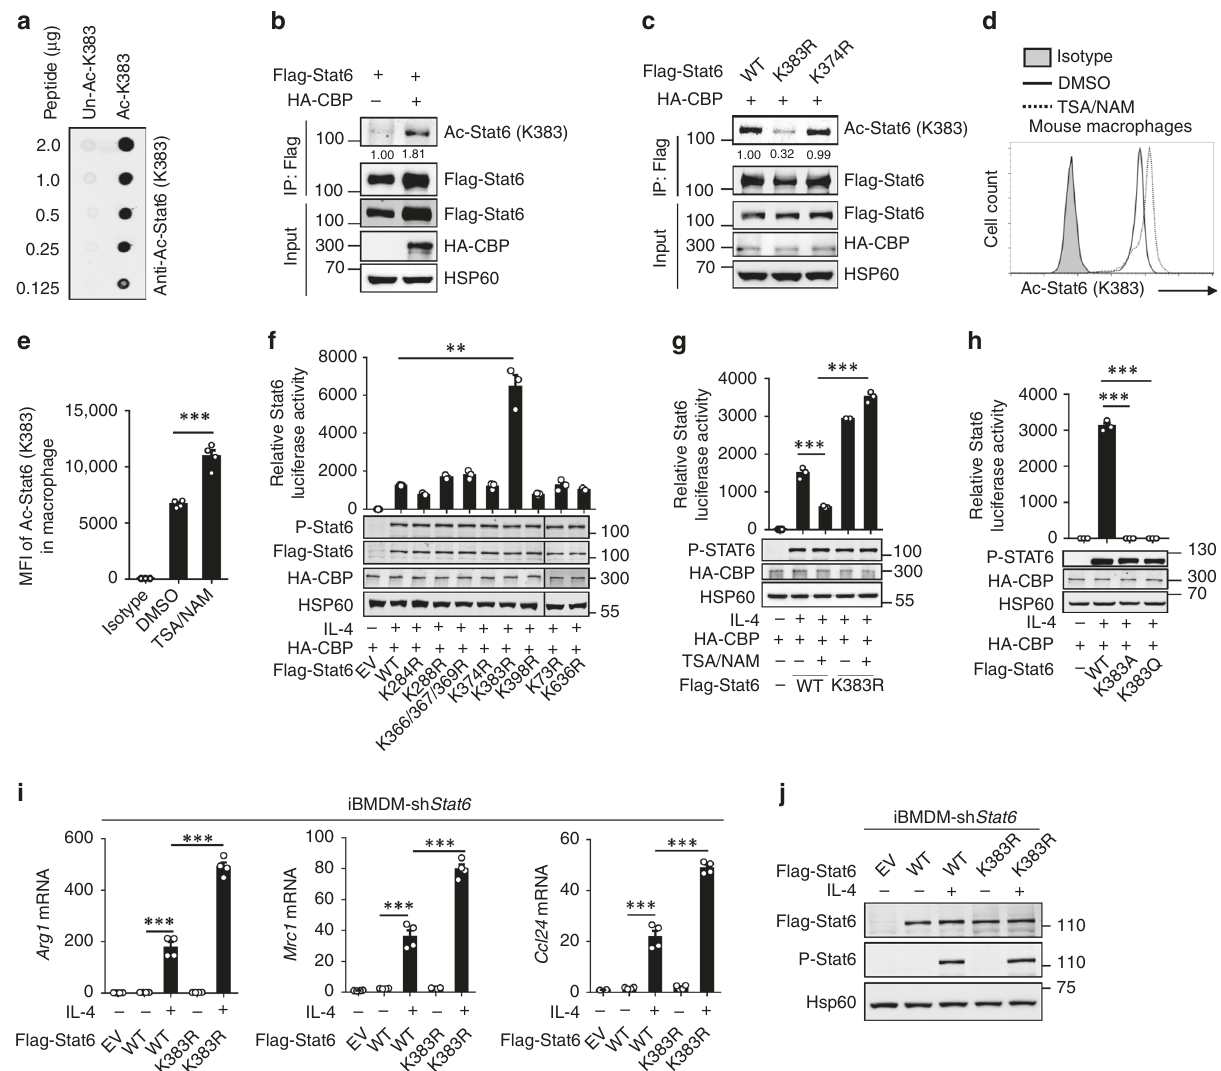
Fig. 2 Lys383 acetylation in Stat6 suppressed its transcriptional activity. a Dot-blot analysis to detect the ef fi ciency of the antibody against Stat6 site- speci fi c (Lys383) acetylation. b , c Immunoblot analysis of the Lys383 acetylation of Stat6 in 293T cells transfected with the indicated expression vectors; lysates were assessed by immunoprecipitation (IP) with anti-Flag and immunoblotting with anti-Ac-Stat6 (K383) and anti-Flag; lysates were immunoblotted to detect input proteins and loading controls before immunoprecipitation. d , e Flow cytometric analysis of the endogenous Stat6 acetylation at Lys383 in murine primary peritoneal macrophages isolated from naive C57BL/6 mice treated with DMSO or trichostatin A (TSA) (5 μ M) plus nicotinamide (NAM) (1 mM) (T/N) for 2 h. Data are presented as a representative histography ( d ) and summary bar graph ( e ). f – h Luciferase assay mutant Stat6 pretreated with DMSO ( − ) or with NAM plus TSA ( g ), and 293T cells transfected with WT or K383A or the K383Q mutant Stat6 ( h ) and